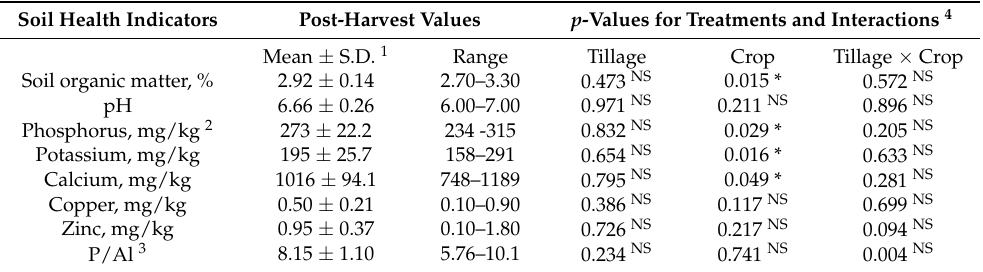
Table 6. Summary statistics and probability of significance ( p -values), calculated from analysis of variance, of the soil health indicators measured after the end of the field